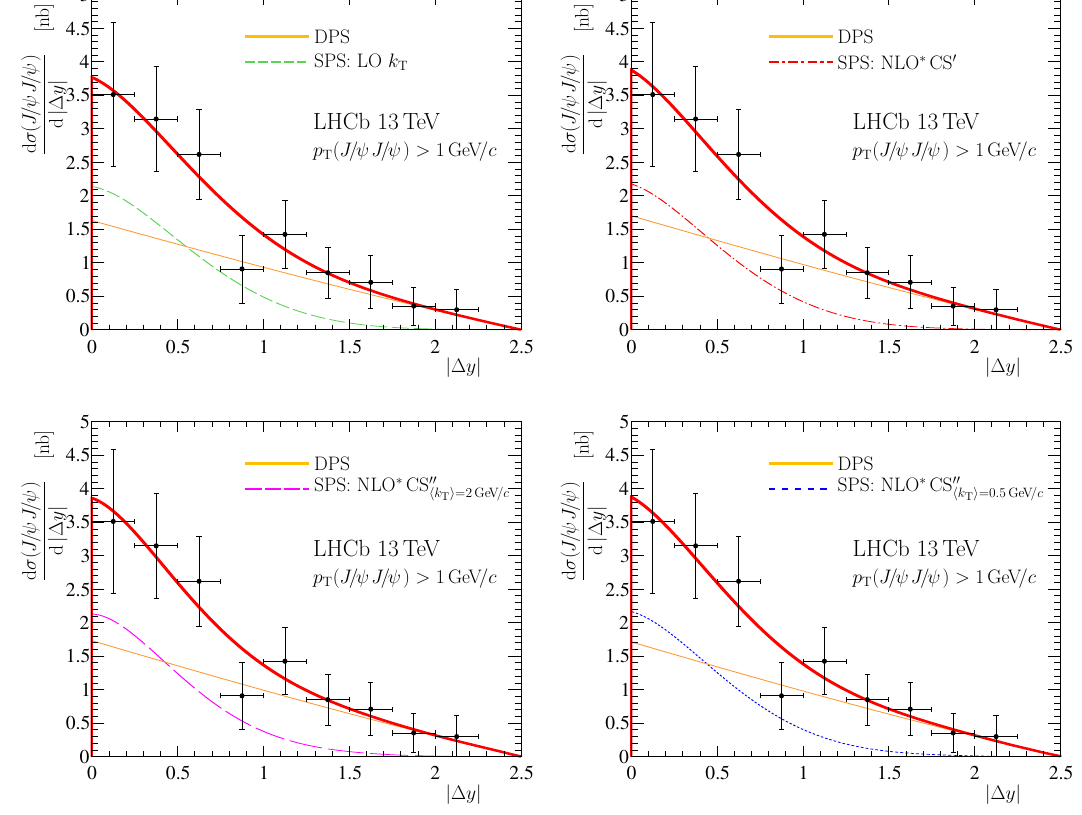
Figure 13. Result of templated DPS (cid:12)t for d (cid:27) ( J= J= ) for the p T ( J= J= ) > 1 GeV =c region. The d j (cid:1) y j (black) points with error bars represent the data. The total (cid:12)t result is shown with the thick (red) solid line and the DPS component is shown with the thin (orange) solid